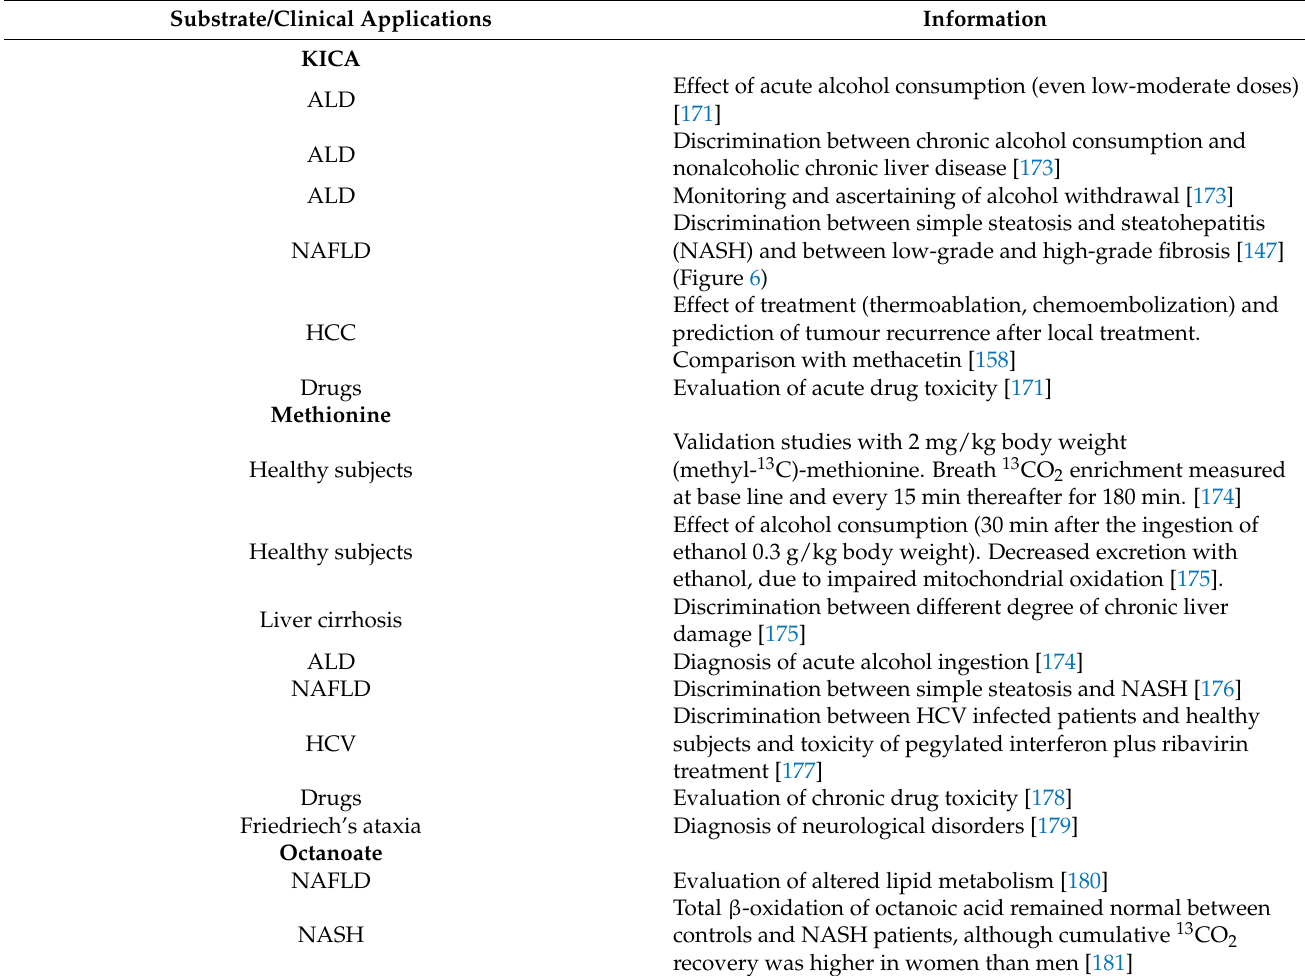
Table 3. Liver mitochondrial breath tests: substrates and evidence for potential clinical applications. Substrate/Clinical